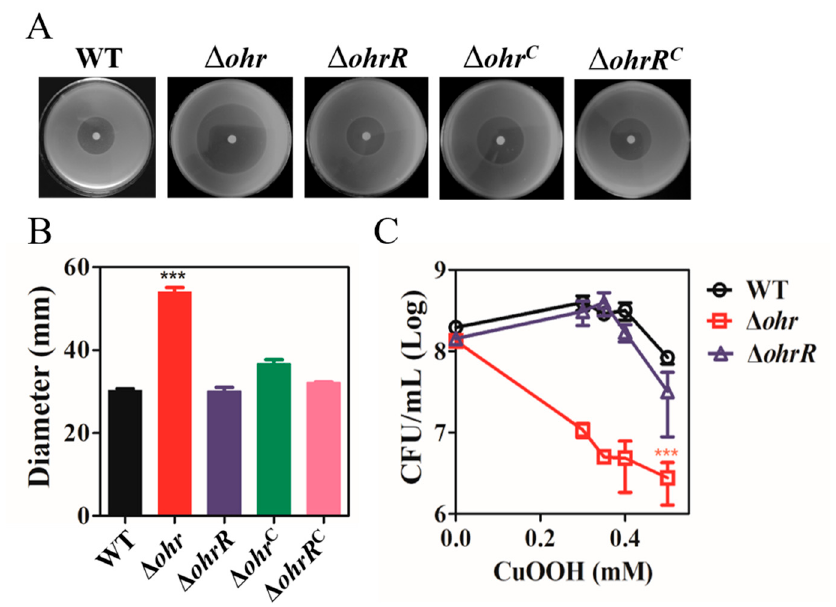
Figure 2. Characteristics of the A. caulinodans mutants in response to CuOOH. ( A , B ) Disk diffusion assay. Approximately 10 7 bacterial cells of A. caulinodans were mixed and spread on TY agar plates. Paper discs of 6 mm in diameter loading with 4 µL CuOOH of 4.88 M were placed on bacterial lawns. Plates were incubated at 28 °C for two days until measurement of inhibition zones. ( C ) Killing assay. CuOOH was added to early-log cultures to the final concentrations as indicated. After incubated for 4 h, samples were properly diluted and plated on TY plates. Colony counting was done after 3 days. Data are mean and SD of three independent experiments. ***: Student t -test P < 0.005, ns: no significant difference.